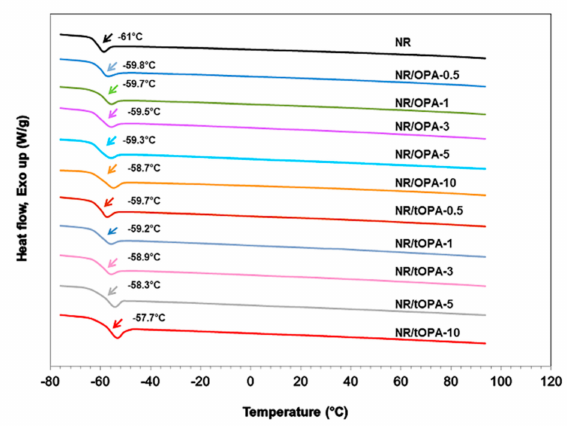
Figure 13. DSC thermogram of unfilled NR and NR/OPA and NR/tOPA at various filler